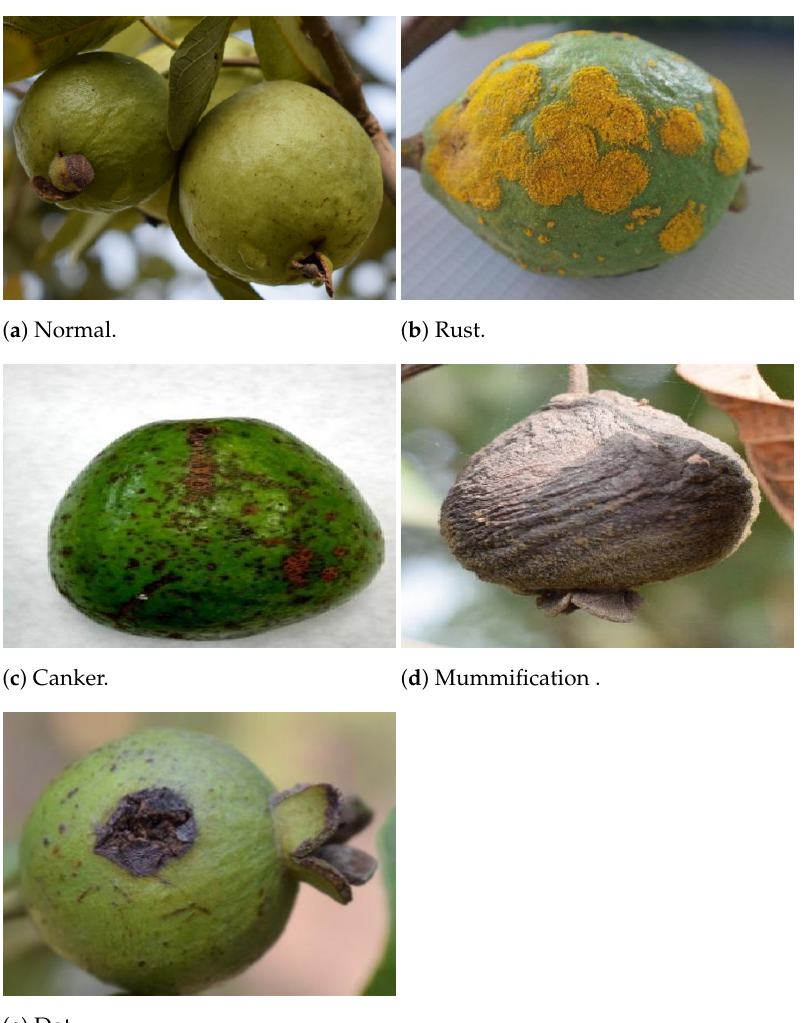
Figure 5. Sample images labeled with each target class (Guava